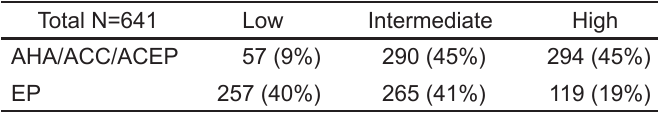
Table 2. AHA/ACC/ACEP guidelines versus emergency physician (EP) risk stratification for ACS.